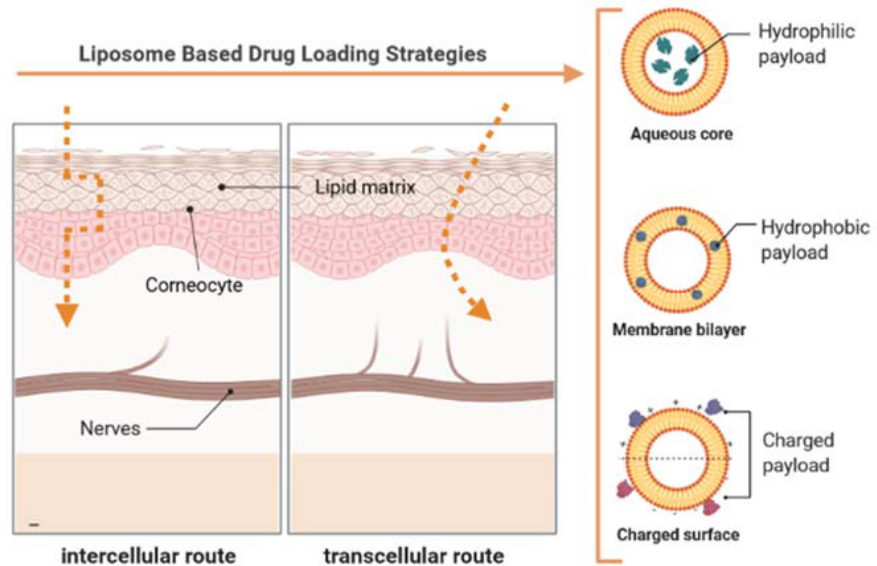
Figure 1. Schematic representation of the compound permeation pathways on the skin (on the left). Permeation occurs mainly through the intercellular and intracellular pathways. The elastic and ultra-deformable liposomes penetrate the skin essentially through the intercellular route since the phospholipid bilayer is flexible and allows its deformation to cross the intercellular spaces. Schematic representation of an ultra-deformable liposomal system to administer APIs (on the